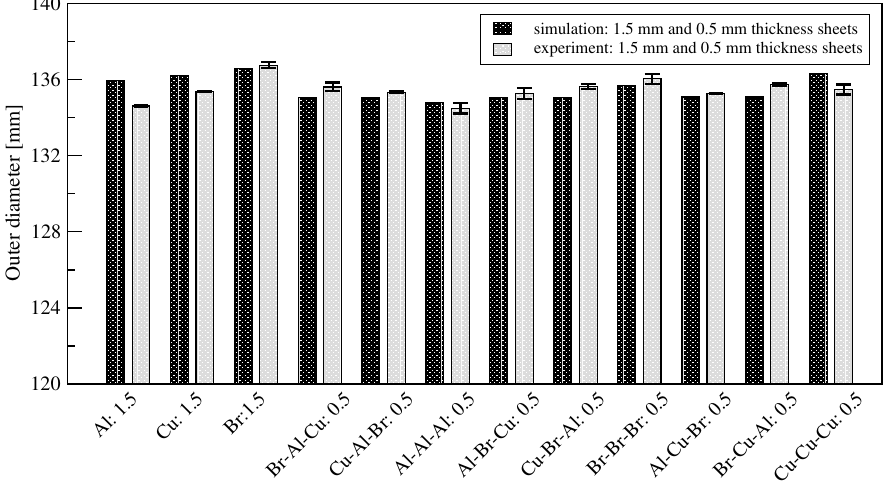
Figure 10. Diameter comparison of numerically- and experimentally-deformed single and stacked metal